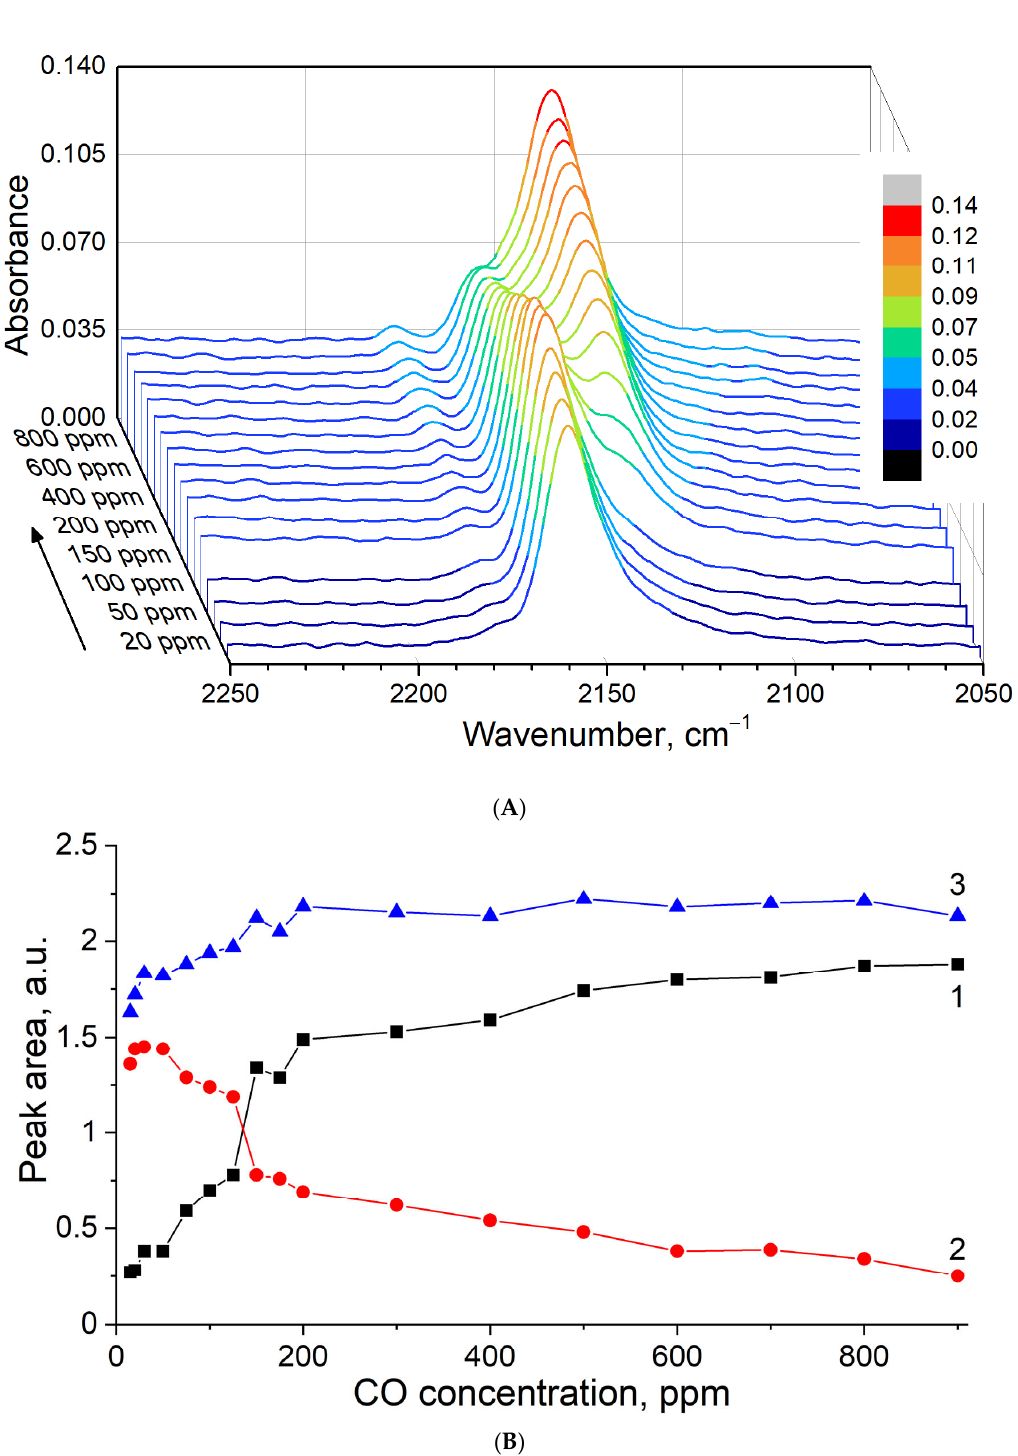
Figure 6. ( A ) Waterfall graph of difference FTIR spectra of CO adsorbed on MOR ‐ Cu(NO 3 ) 2 in Ar flow. For all waterfall data sets, the spectra are offset for clarity, and the colour legend represents the absorbance scale. ( B ) Evolution of the peak areas: 2135 cm − 1 peak (1), 2157 cm − 1 peak (2) and total peak area (3) of CO adsorbed on Cu(NO 3 ) 2 ‐ MOR.